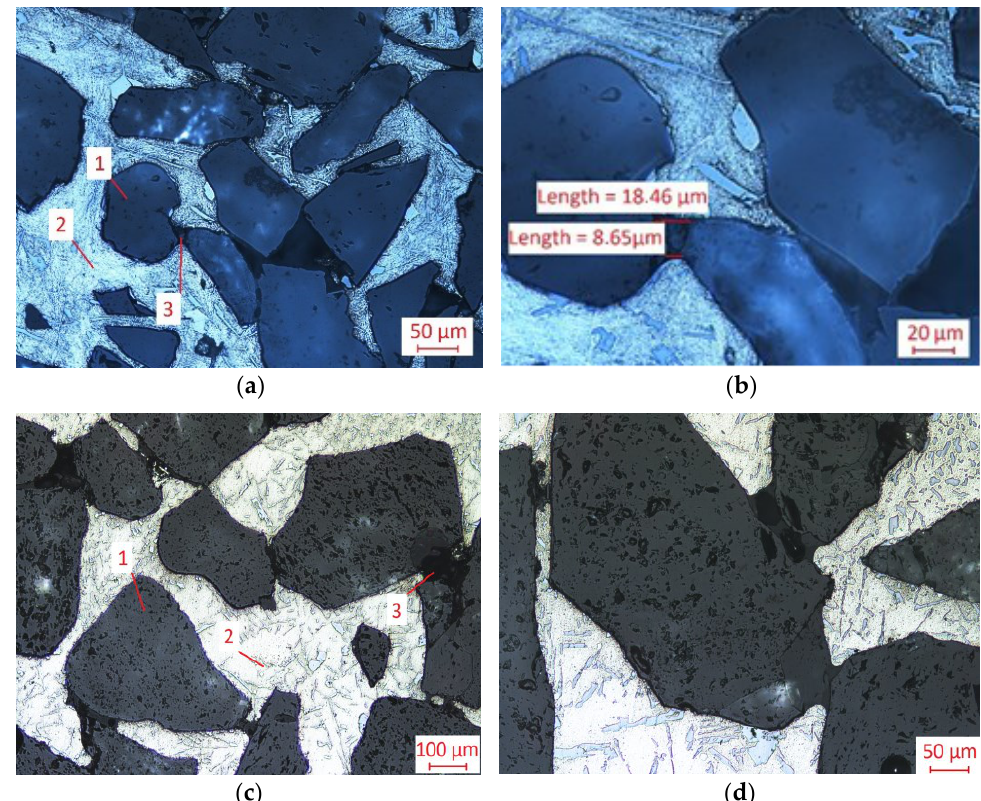
Figure 1. The metallographic examination of FEPA 100: ( a ) 1 — Al 2 O 3 sinter (reinforcement), 2 — AlSi 11 alloy (matrix phase), 3 — porosity (50 µm), and ( b ) enlarged porosity (20 µm); and FEPA 046: ( c ) 1 — Al 2 O 3 sinter (reinforcement), 2 — AlSi 11 alloy (matrix phase), 3 — porosity (100 µm), and ( d ) enlarged porosity (50 µm).